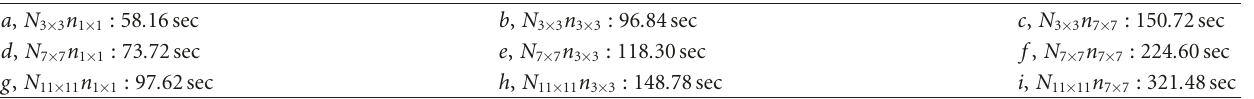
Table 7: CPU times in terms of seconds needed for above restorations using the proposed SA prior with the corresponding neighborhood combinations in Table